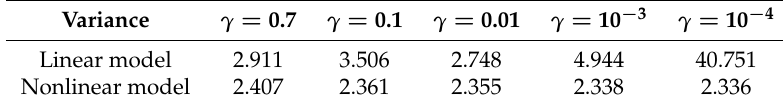
Table 1. Final HTF temperature variance comparison.